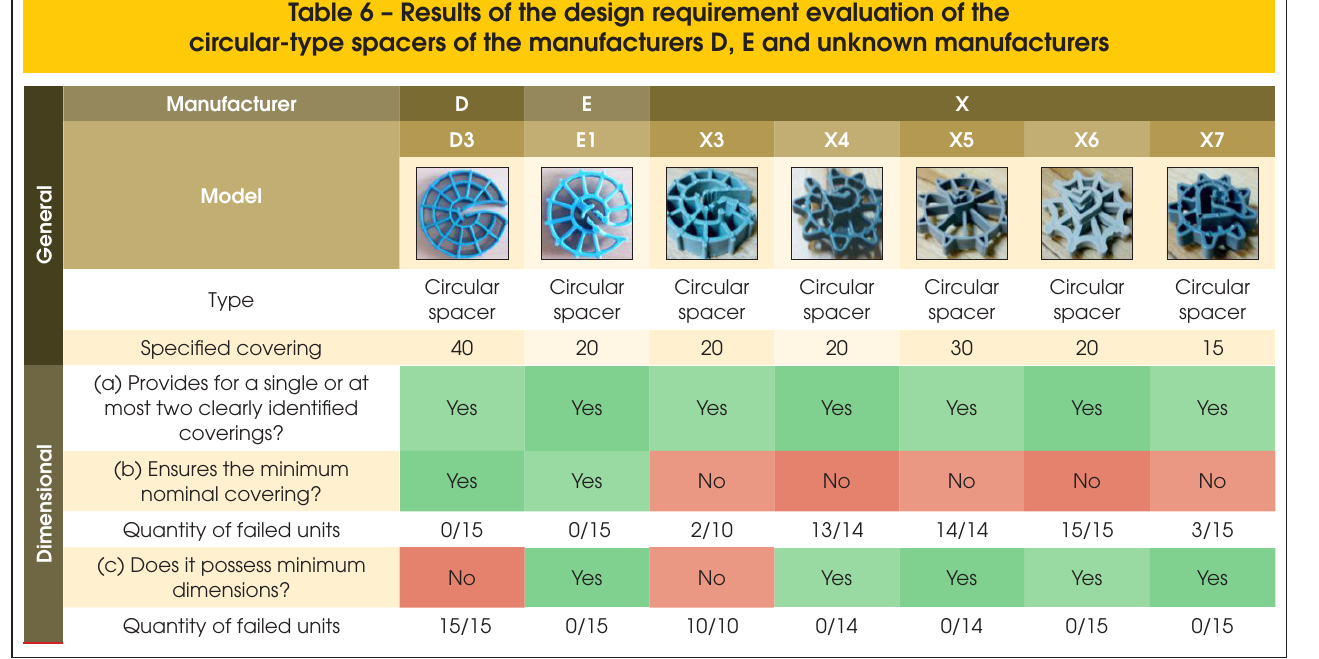
Table 6 – Results of the design requirement evaluation of